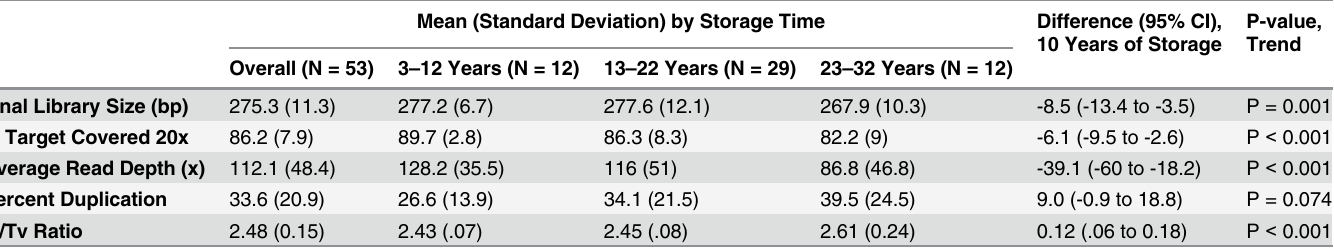
Table 4. Whole Exome Sequencing QC metrics by duration of specimen